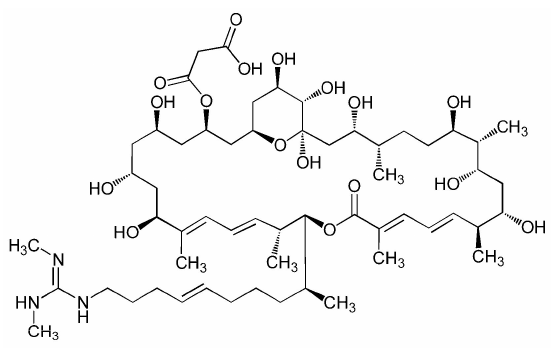
Figure 1. The chemical structure of azalomycin F 5a